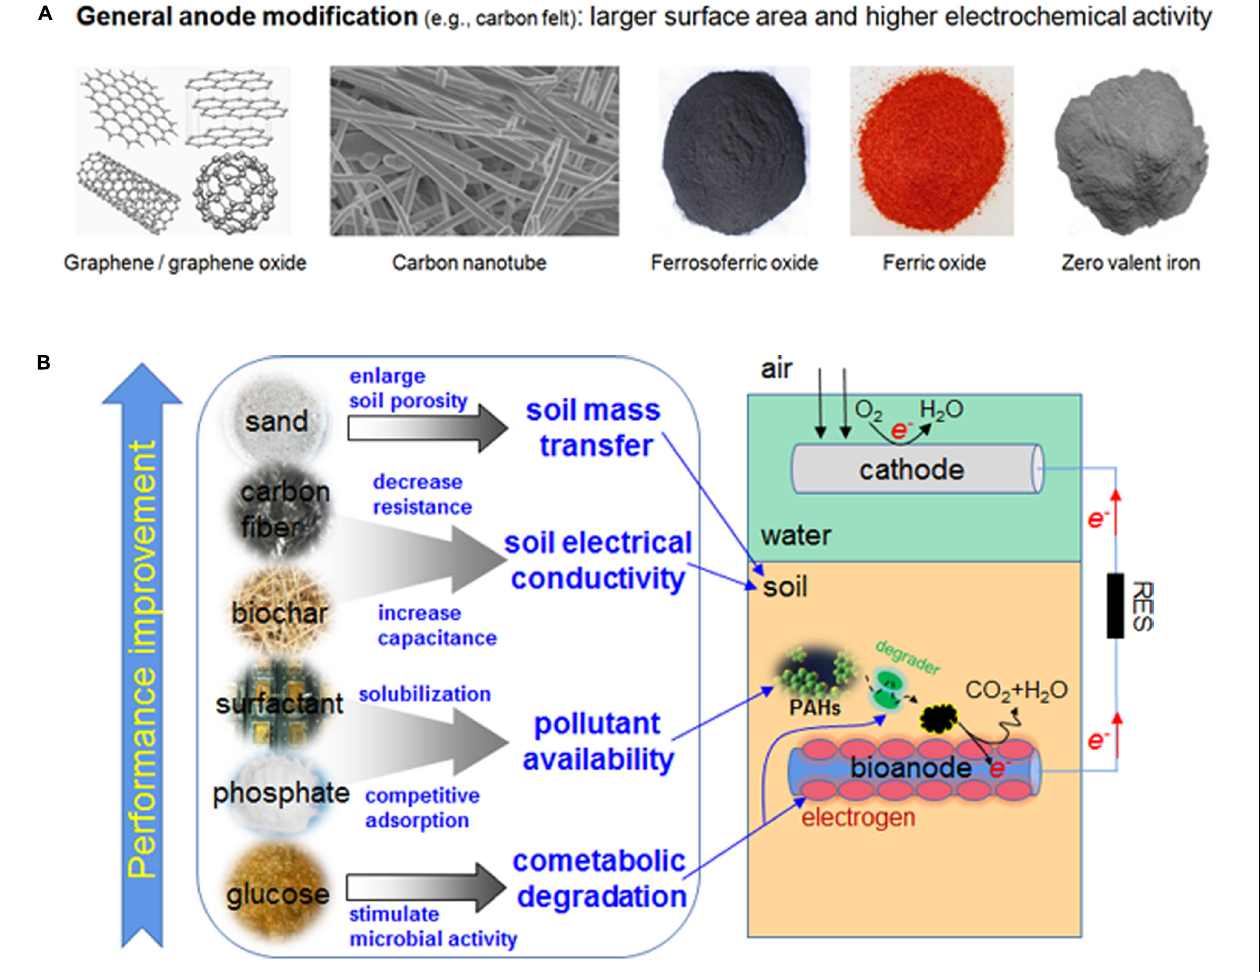
FIGURE 2 | (A) Examples of materials used for anode modifications of MFC; (B) example methods of improving MFC performance in PAH degradation.